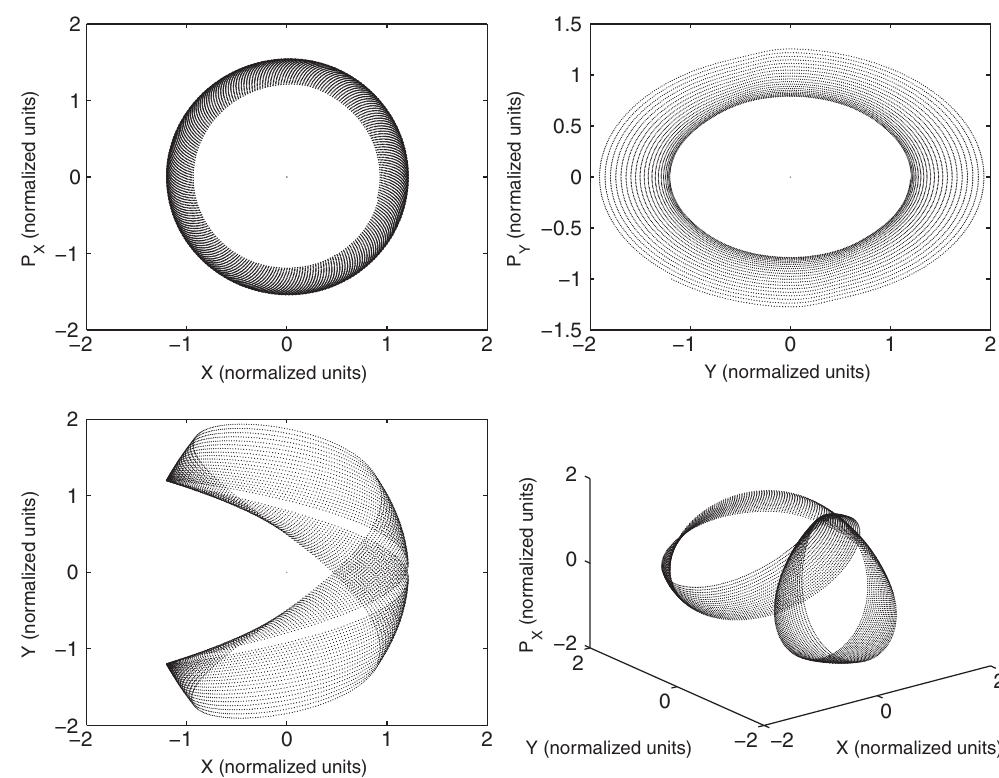
FIG. 7. Exactly integrable case, separable in parabolic coordinates. The four subplots show the same projections as in previous figures. The initial conditions are x ¼ (cid:1) 1 : 2 , p